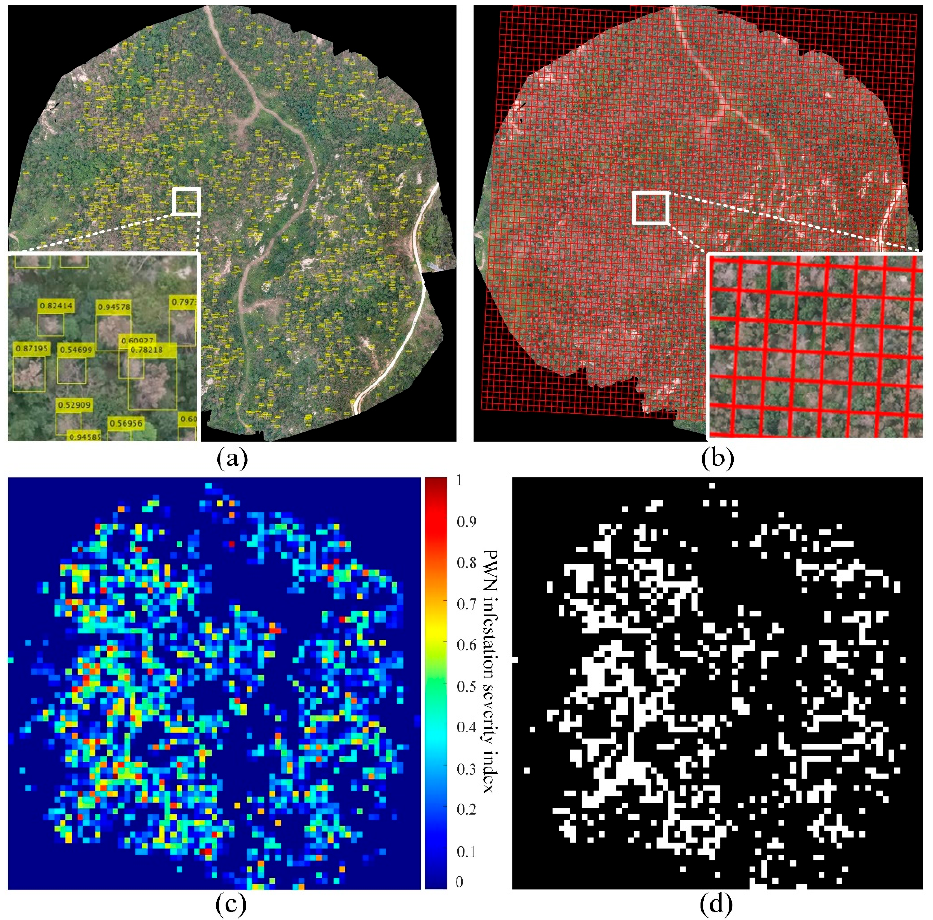
Figure 3. Deep-learning-based infested tree detection and Radarsat-2-scale infestation map produc- tion of an example forest plot. ( a ) Detection of infested trees from UAV images; ( b ) footprints of Radarsat-2 pixels onto UAV images; ( c ) Radarsat-2-scale infestation severity map; ( d ) Radarsat-2-scale infestation map with infestation severity of larger than 0.25.